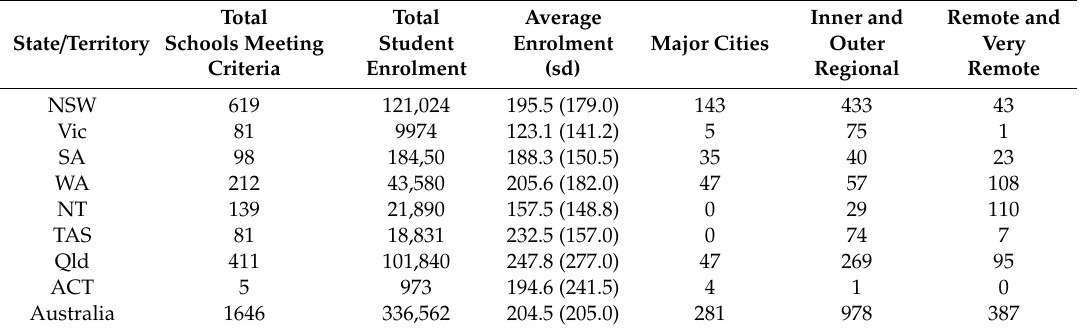
Table 1. All primary / combined schools where ICSEA is less than 1050 and / or Aboriginal enrolments are 12% or more, by state and territory, 2017 1 .